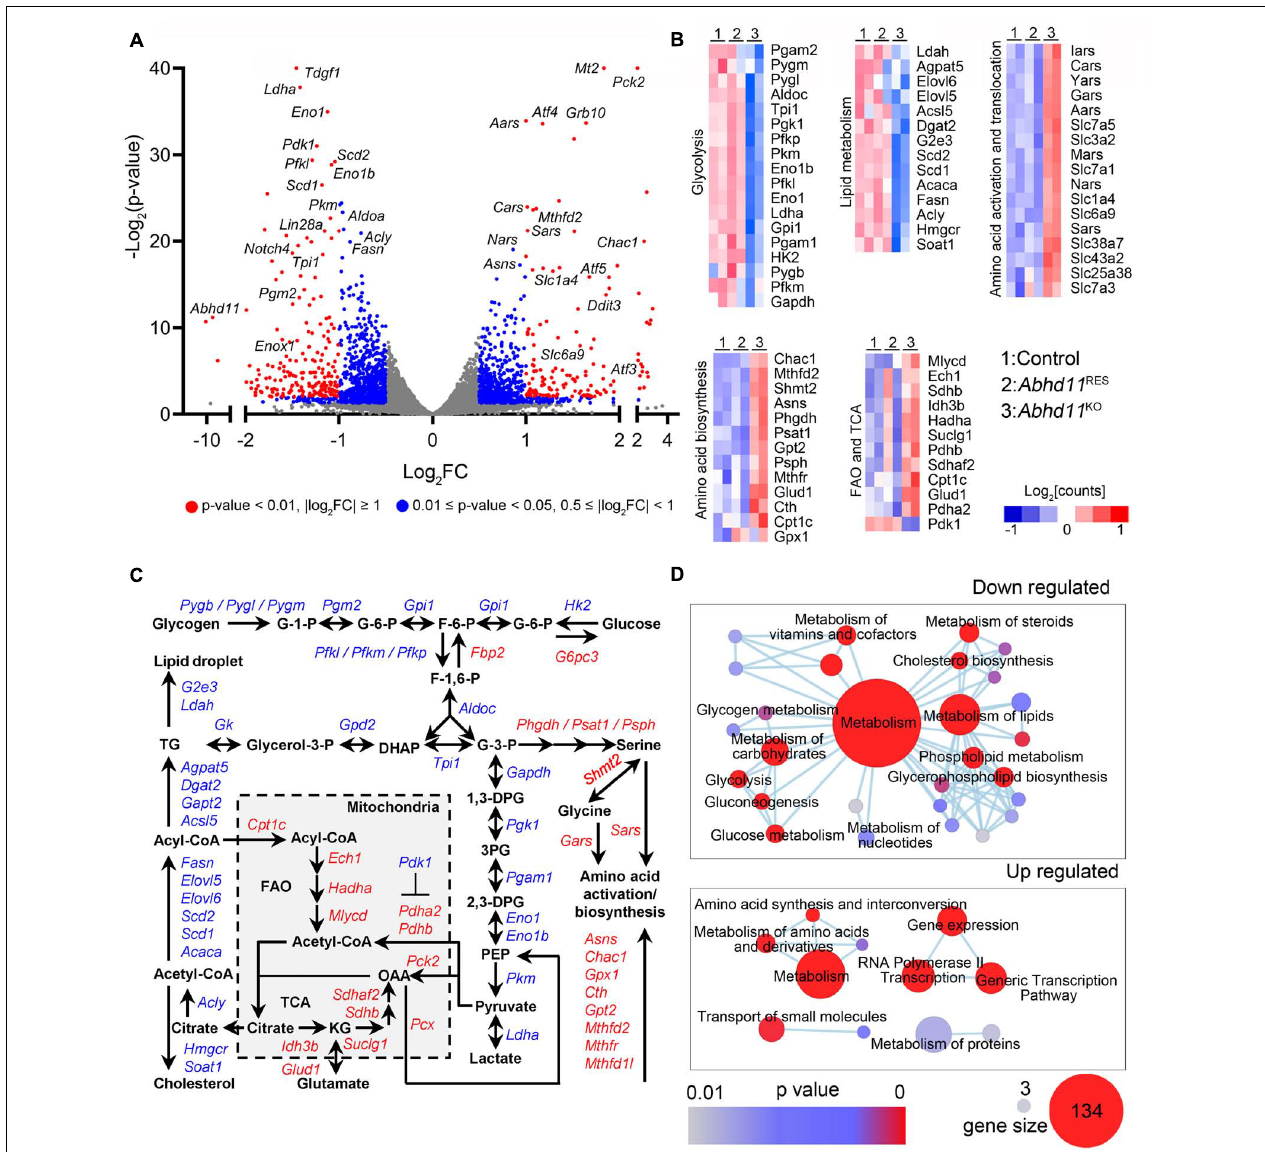
FIGURE 7 | Abhd11 KO causes the misexpression of metabolic genes. (A) Volcano plot of DEGs in P3 Abhd11 KO ESCs versus control ESCs. FC, fold change. (B) Heatmap of metabolic genes differentially expressed in Abhd11 KO ESCs versus control ESCs. (C) Biochemical pathways of genes that are up-regulated (red) and down-regulated (blue) as a result of Abhd11 depletion. G-1-P, glucose 1-phosphate; G-6-P, glucose 6-phosphate; F-6-P, fructose 6-phosphate; F-1,6-P, fructose 1,6-biphosphate; G-3-P, glyceraldehyde 3-phosphate; DHAP, dihydroxy acetone phosphate; 1,3 DPG, 1,3-diphosphoglyceric acid; 3PG, 3-Phosphoglycerate; 2,3-DPG, 2,3-diphosphoglycerate; PEP, Phosphoenolpyruvate; OAA, oxaloacetate; FAO, fatty acid oxidation; TCA, citric acid cycle; KG, α -ketoglutarate; TG, triglyceride. (D) Enrichment map networks of reactome terms corresponding to down-regulated genes (upper panel, a part of the total networks that was